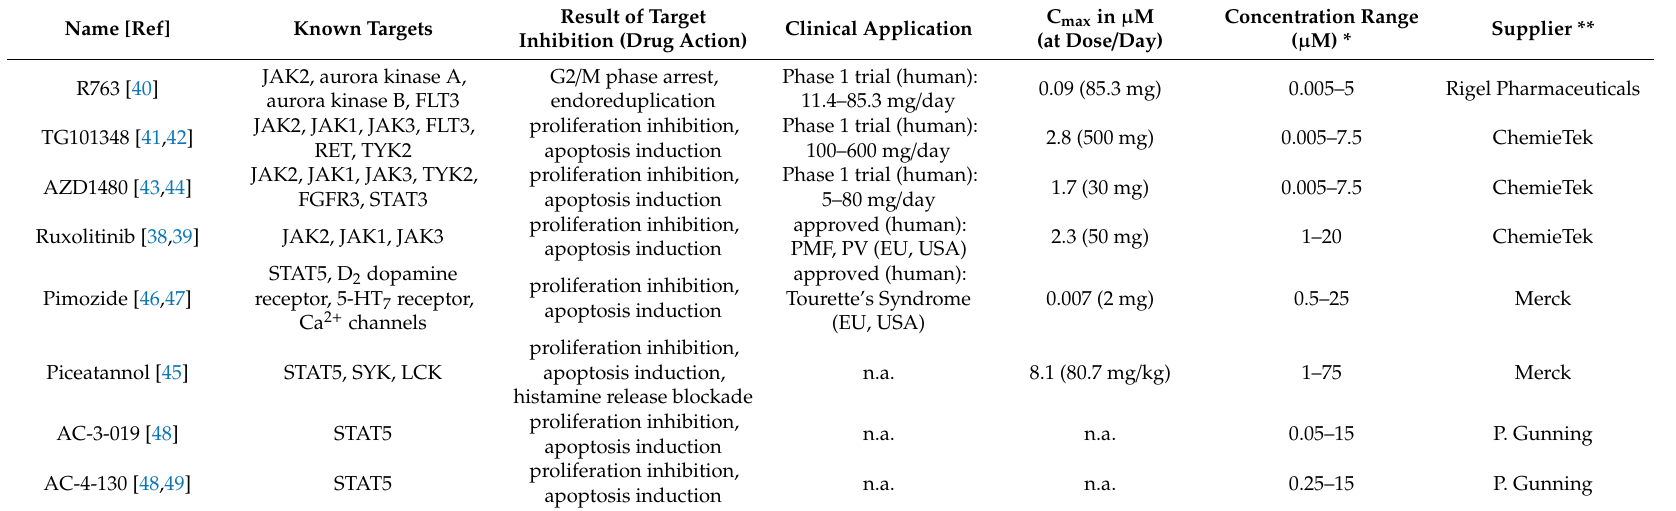
Table A2. Specifications of inhibitors used in this